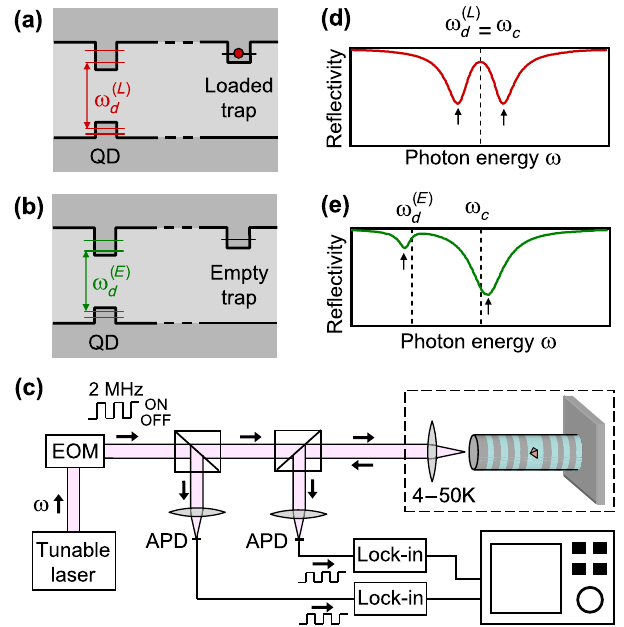
FIG. 1. (a),(b) Band structures of an InGaAs QD with a nearby loaded orempty trap, correspondingtoQD transition energies ω ð E Þ and ω d . (c) Experimental setup (EOM, electro-optic modulation system; APD, avalanche photodiodes). (d),(e) Typical reflectivity spectra for a loaded and for an empty trap, in the special casewhere ω ð L Þ ¼ ω ω ð E Þ < ω c but c . The vertical arrows underline the d d energies of the mixed exciton-photon eigenstates.